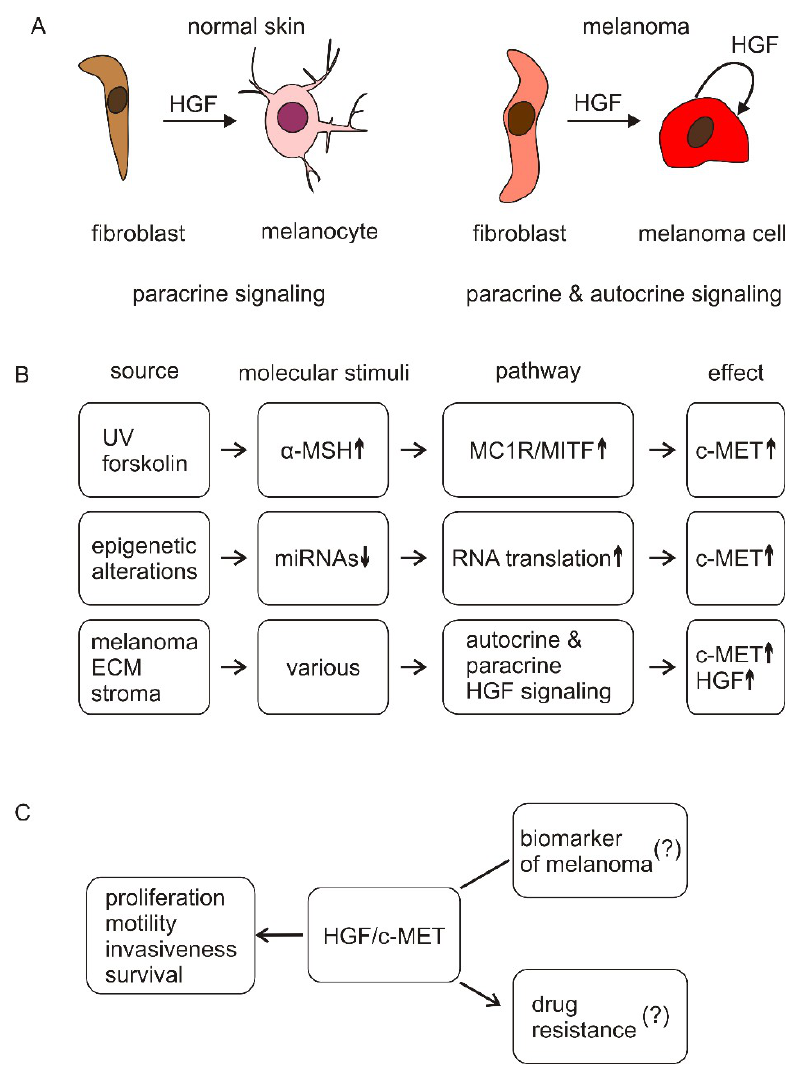
Figure 2. Simplified schematic illustration of the regulation of c-MET expression and activity in melanoma cells. ( A ) In normal skin, HGF is released mainly by fibroblasts to induce changes in melanocytes (paracrine signaling). In melanoma, autocrine signaling is also observed; ( B ) c-MET expression can be increased in melanoma cells through different mechanisms, including transcriptional regulation by MITF and reduced level of miRNAs targeting c-MET transcript. Activity of c-MET can be enhanced by elevated level of HGF produced and released by stromal cells (paracrine signaling) and melanoma cells (autocrine signaling) in response to diverse molecular stimuli, and with the regulatory contribution of ECM; Up- and down-arrows show enhanced and reduced levels of indicated molecules, respectively; ( C ) The enhanced activity of HGF/c-MET signaling in melanoma cells plays an important role in melanoma progression by supporting proliferation, survival, motility, and invasiveness, including niche formation. It is unclear whether HGF and/or c-MET are melanoma biomarkers, or whether the HGF/c-MET signaling contributes to the development of resistance to oncoprotein-targeted therapies.